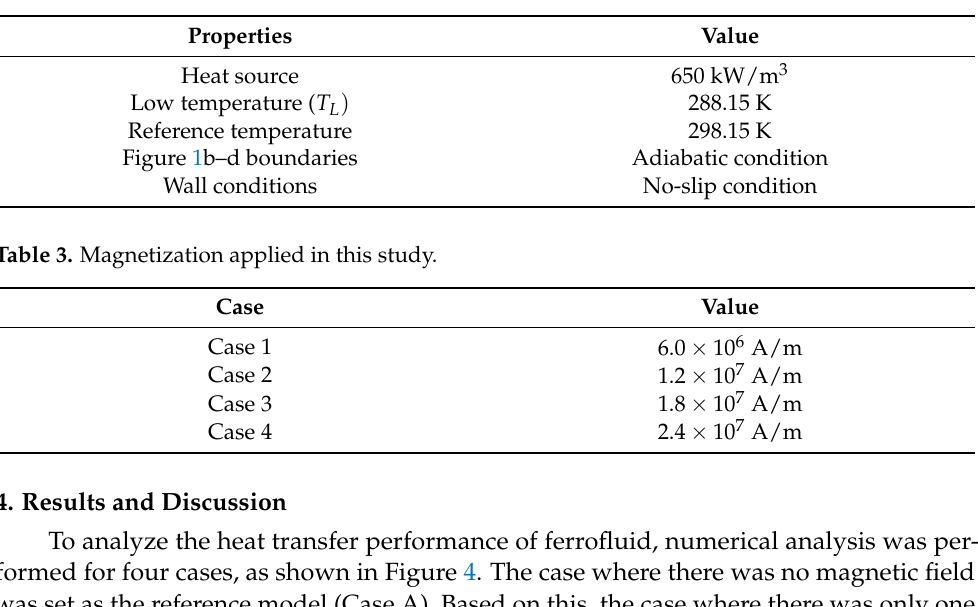
Table 2. Boundary conditions applied in this study.